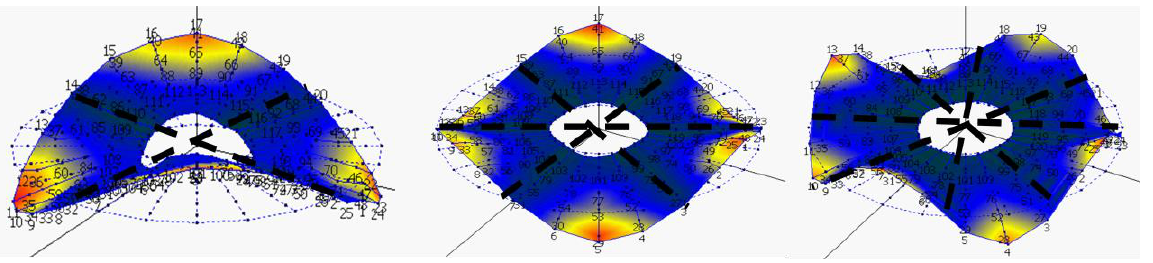
Figure 2. n = ±2, n = ±3, n = ±4 for the disk rotating in air, viewed from the rotating